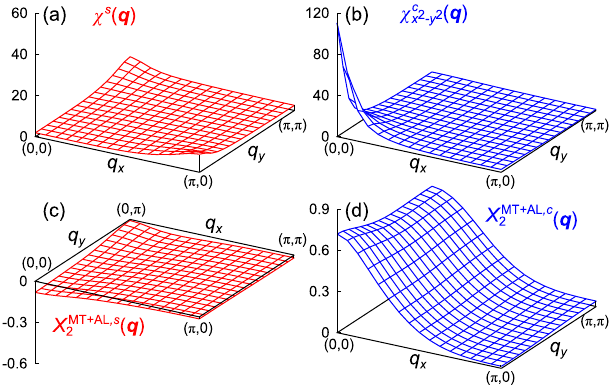
FIG. 7. (a) χ s ð q Þ and (b) χ c